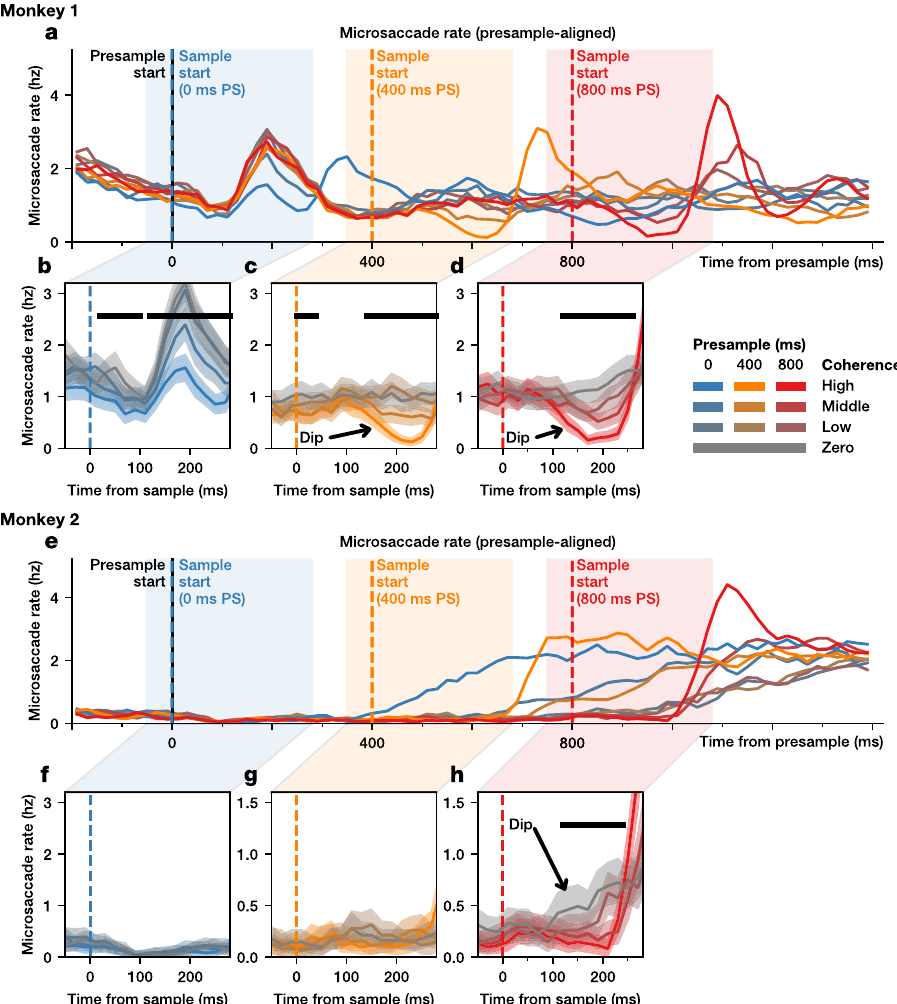
Fig. 7 Dips in microsaccade rate. Microsaccade rate is shown for all trials, aligned to the presample onset, for Monkey 1 ( a ) and Monkey 2 ( e ). Highlighted are the microsaccade rates centered around the onset of the sample during trials with 0 ms ( b , f ), 400 ms ( c , g ), and 800 ms ( d , h ) presample for Monkey 1 ( b – d ) and Monkey 2 ( f – h ). The black bar indicates signi fi cance ( p < 0.05, one-tailed test for a decrease in the mean, bootstrapping across neurons). Shaded region represents bootstrapped 95% con fi dence interval of the